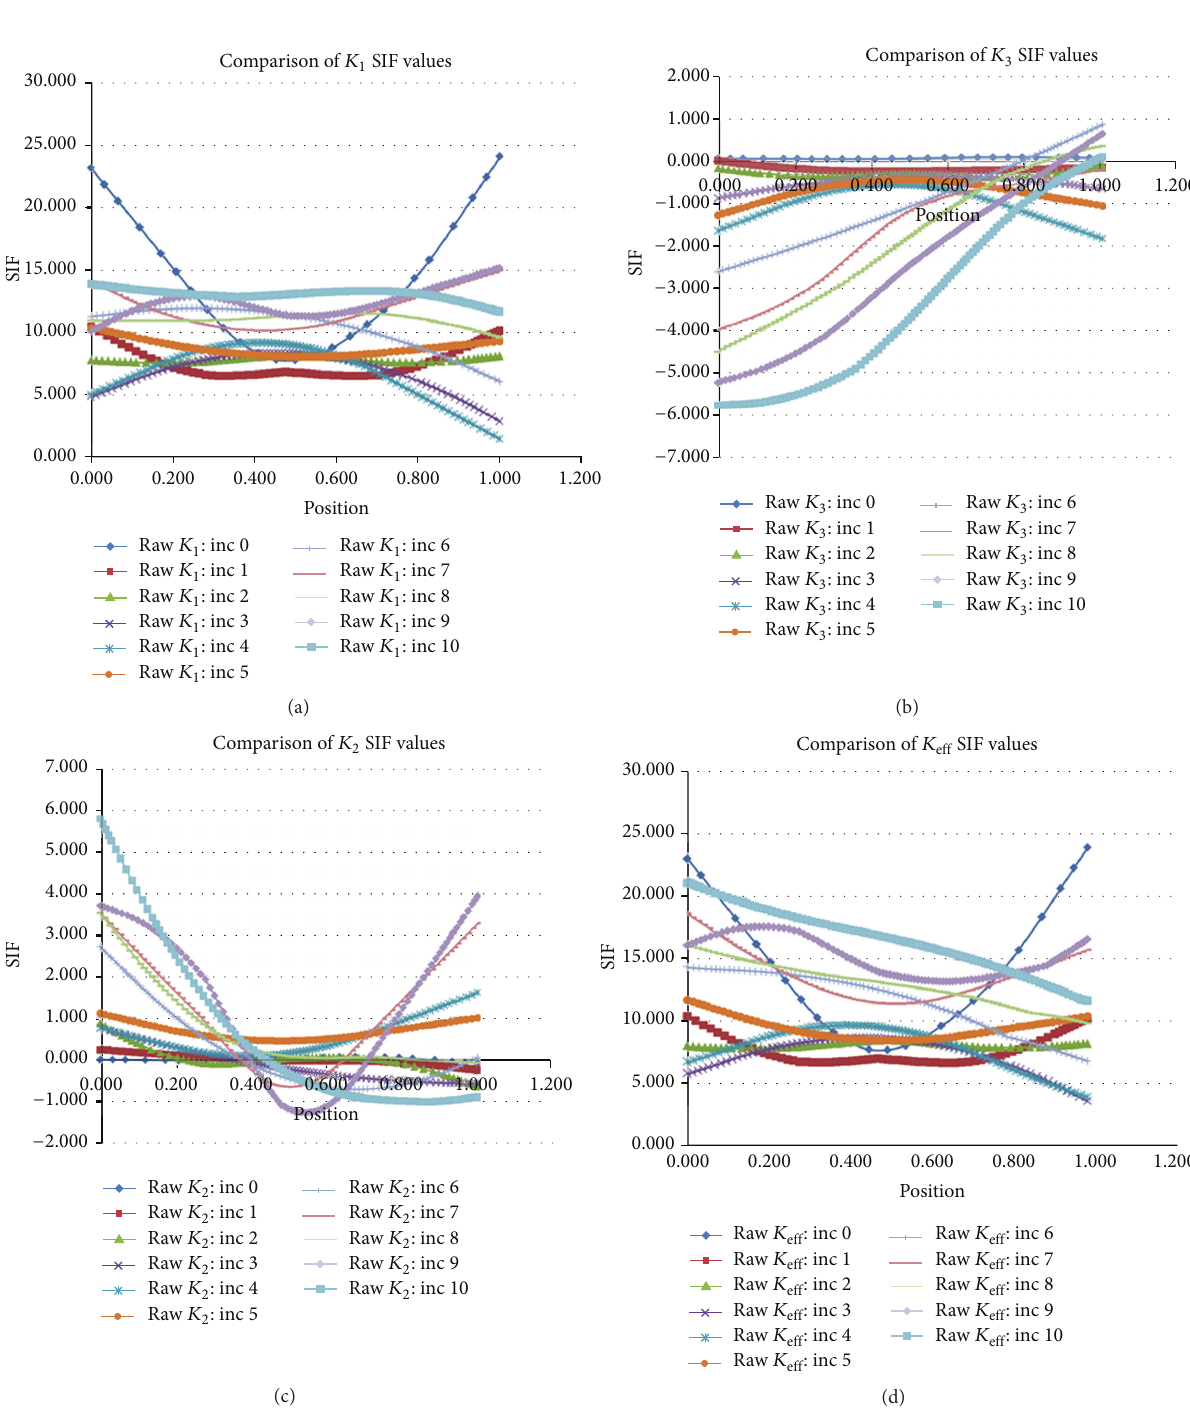
Figure 10: Stress concentration factors of cracks in various crack growing